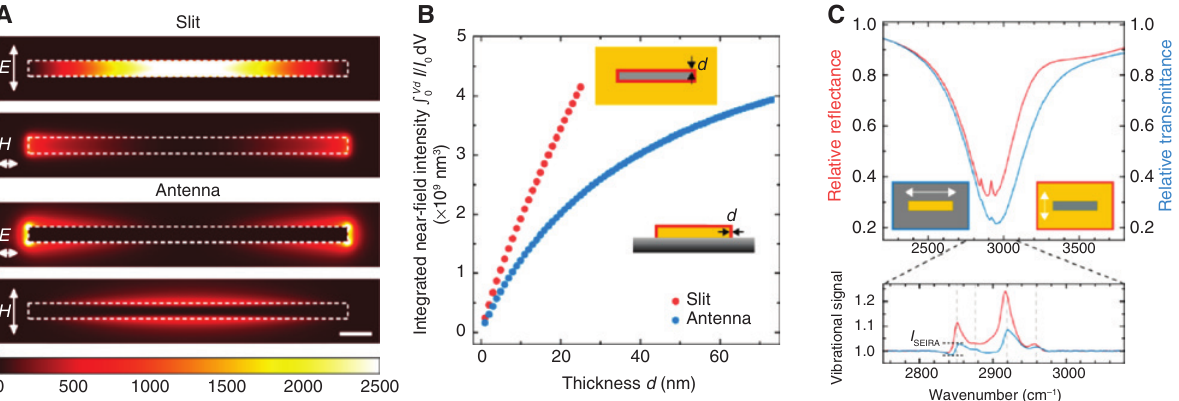
Figure 16: (A) Near-field intensity distribution of a resonantly excited nanoantenna array as well as a nanoslit array in a plane parallel to the substrate at half height of the nanoslit/nanoantenna (scale bar: 100 nm). (B) Near-field intensity integrated over a shell volume surround- ing the nanostructure (see inset) with increasing thickness d . (C) Relative IR reflectance (transmittance) of a nanoslit (nanoantenna) array covered with a monolayer of ODT. The dimensions of both arrays are w = 50 nm, Δ x = Δ y = 1.7 μ m and L lower panel shows the baseline-corrected vibrational signal of the ODT molecule. Adapted with permission from Ref. [128]. Copyright 2015 American Chemical